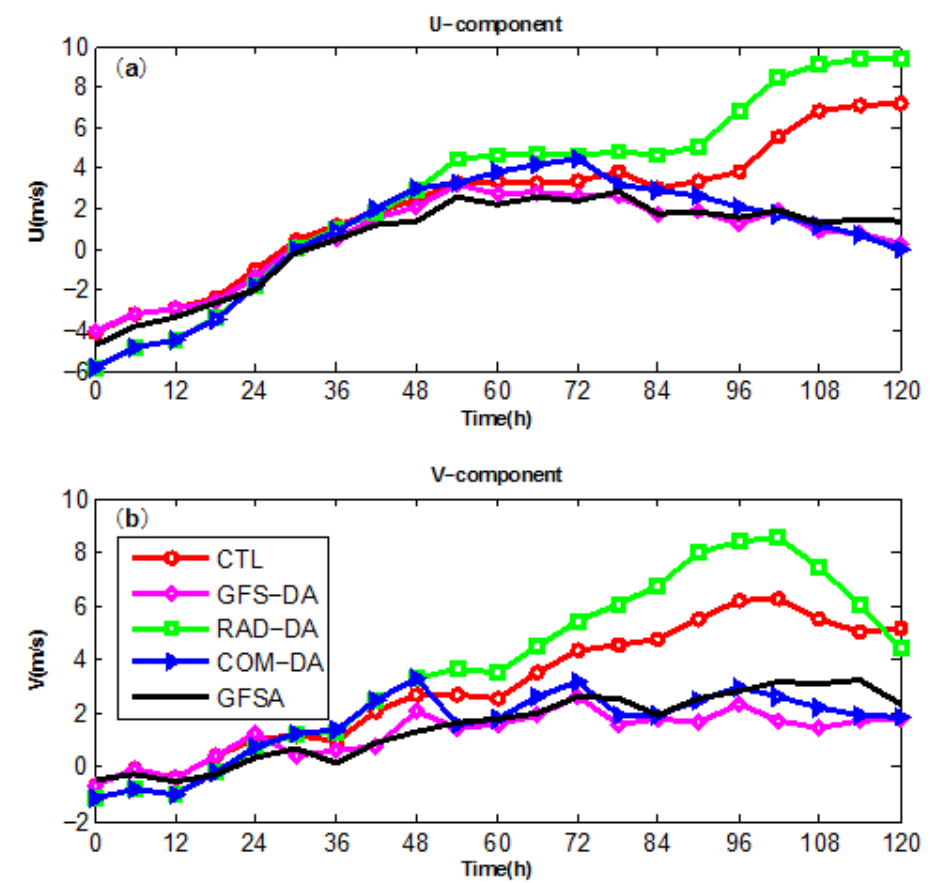
Figure 10. Values of the ( a ) u and ( b ) v components of the steering flows at different forecast times for each experiment (unit: m s − 1 ). The steering flows from the GFS analysis (OBS, in black) are also given as references.